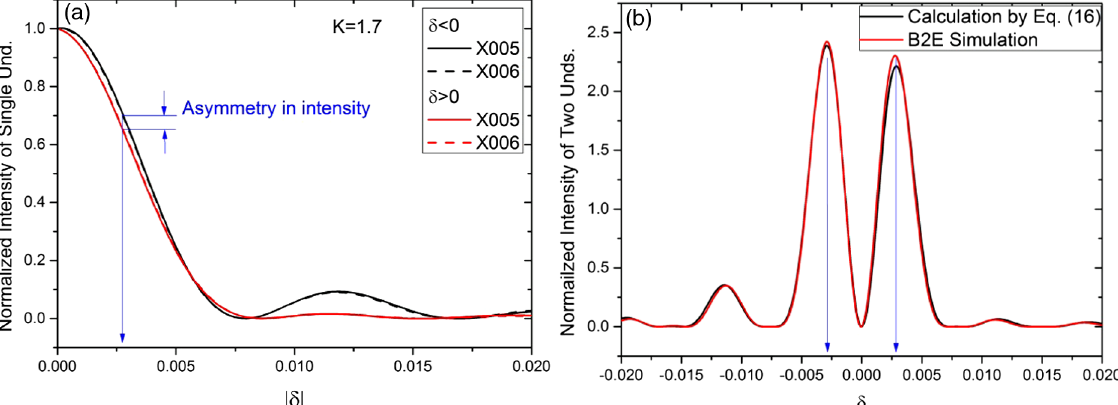
FIG. 14. (a) Symmetry test of single undulator spectra. Black curves δ < 0 ; red curves δ > 0 . There is again very good agreement between the two undulators. The asymmetry in the spectrum is clearly seen on both. (b) Double undulator spectra for the antimatched π . Black curve: Combination of single undulator spectrum and Eq. (16). Red curve: Full B2E phase, φ PS ¼